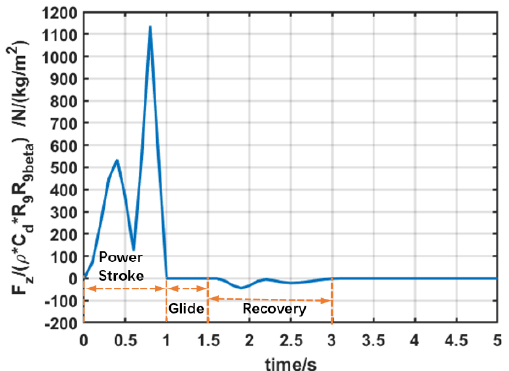
Figure 11. The estimated force generated using the designed mech- anism in a swimming cycle.